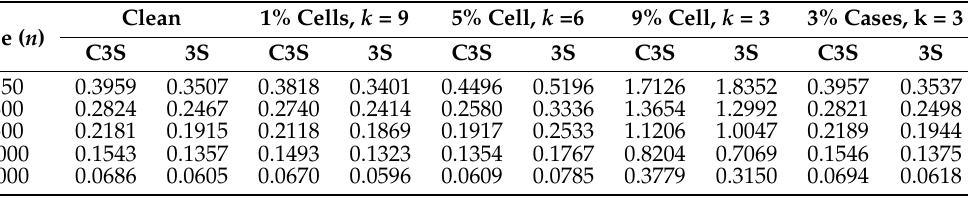
Table 5. Average CIL for clean data and for cell-wise and case-wise contamination.